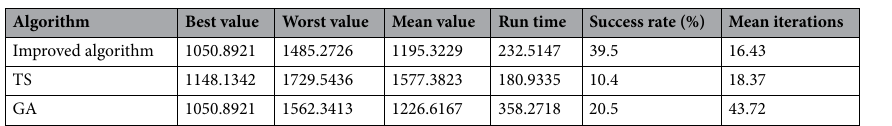
Table 5. Algorithm performance comparison analysis.